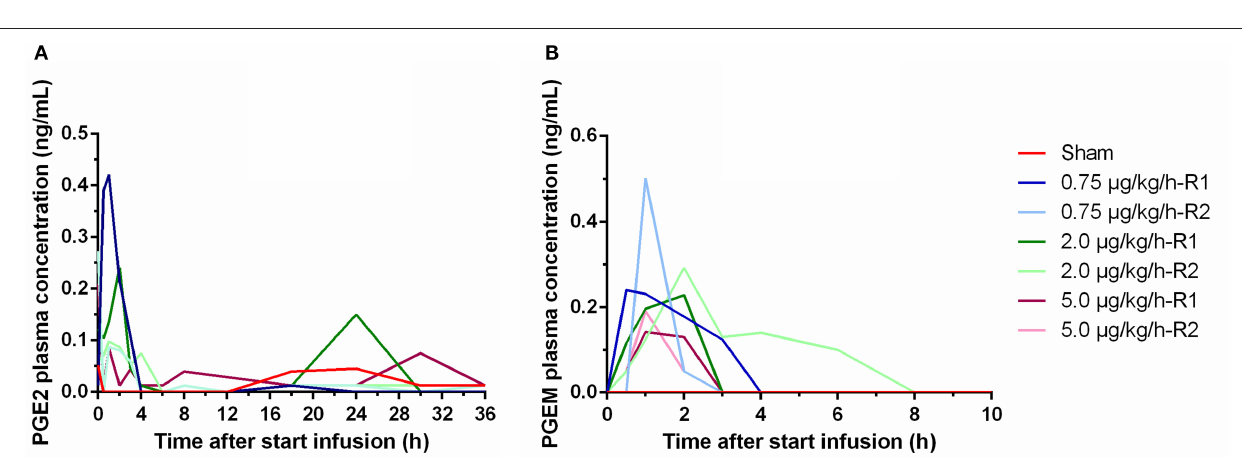
FIGURE 4 | Plasma concentrations of PGE 2 (A) and 13,14-dihydro-15-keto PGE2 (PGEM) (B) over time during a 36h continuous intravenous infusion of either 0.9% NaCl solution (6 ml/kg/h, sham, n = 1) or 0.9% NaCl solution (6 ml/kg/h) in combination with LPS (0.75; 2.0, and 5.0 µ g/kg/h, n = 2/group). Values below LOQ were depicted as LOQ/2, values below the LOD were set as